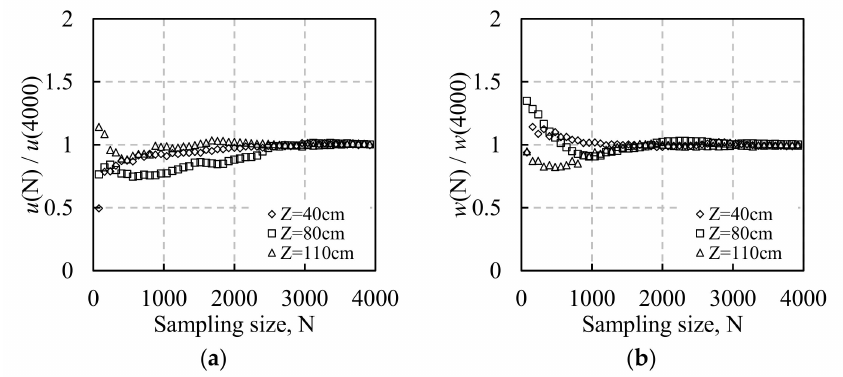
Figure 5. Variation of the RMS velocity with the sampling size when the sampling frequency is 1000 Hz: ( a ) RMS velocity in the X direction; ( b ) RMS velocity in the Z direction.